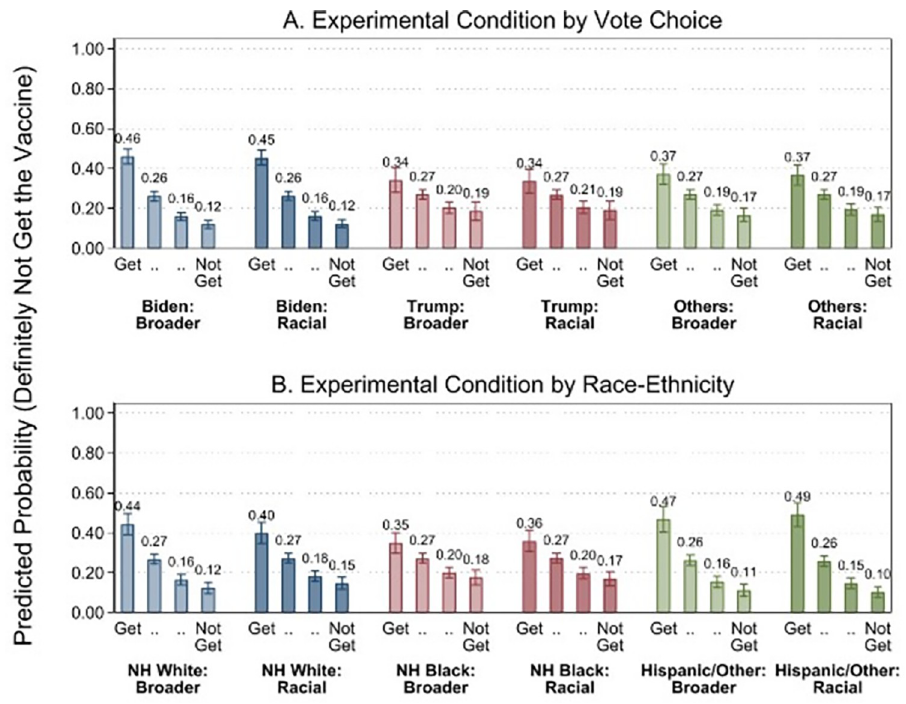
Fig 3. Predictive margins, experimental conditions by race/ethnicity and vote choice. Notes: DV = Definitely will not get the vaccine (3), Probably will not get the vaccine (2), Probably will get the vaccine (1), Definitely will get the vaccine (0). Controls included: gender, age, education, income, co-morbidities, family member died from COVID.